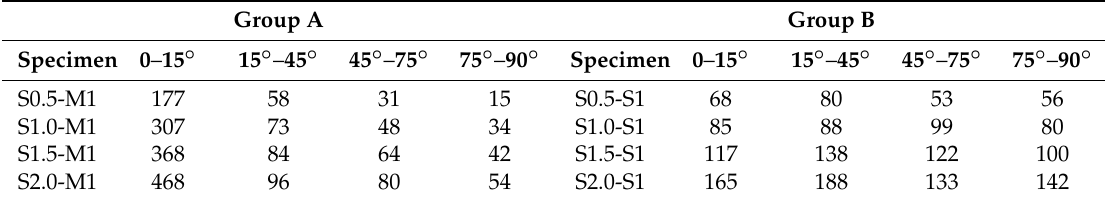
Figure 8. Different orientation of the steel fibers: ( a ) Magnetic method vibration; ( b ) Shaking table vibration. Table 9. Test results of fiber